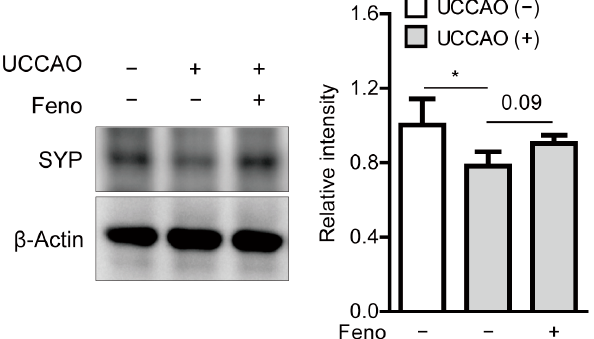
Figure A6. A slight increase in expression of retinal synaptophysin (SYP) by oral administration of fenofibrate in the UCCAO-operated mice. A representative image and quantitative analysis (n = 4–5 per group) show that SYP expression in the retina decreased 12 days after UCCAO and its reduction was slightly suppressed by oral administration of fenofibrate. * p < 0.05 (one-way ANOVA), p = 0.09 (Student’s t -test). The data were analyzed using one-way ANOVA followed by a Bonferroni post hoc test and Student’s t -test, and presented as mean ± standard deviation. Feno; fenofibrate. UCCAO; unilateral common carotid artery occlusion.